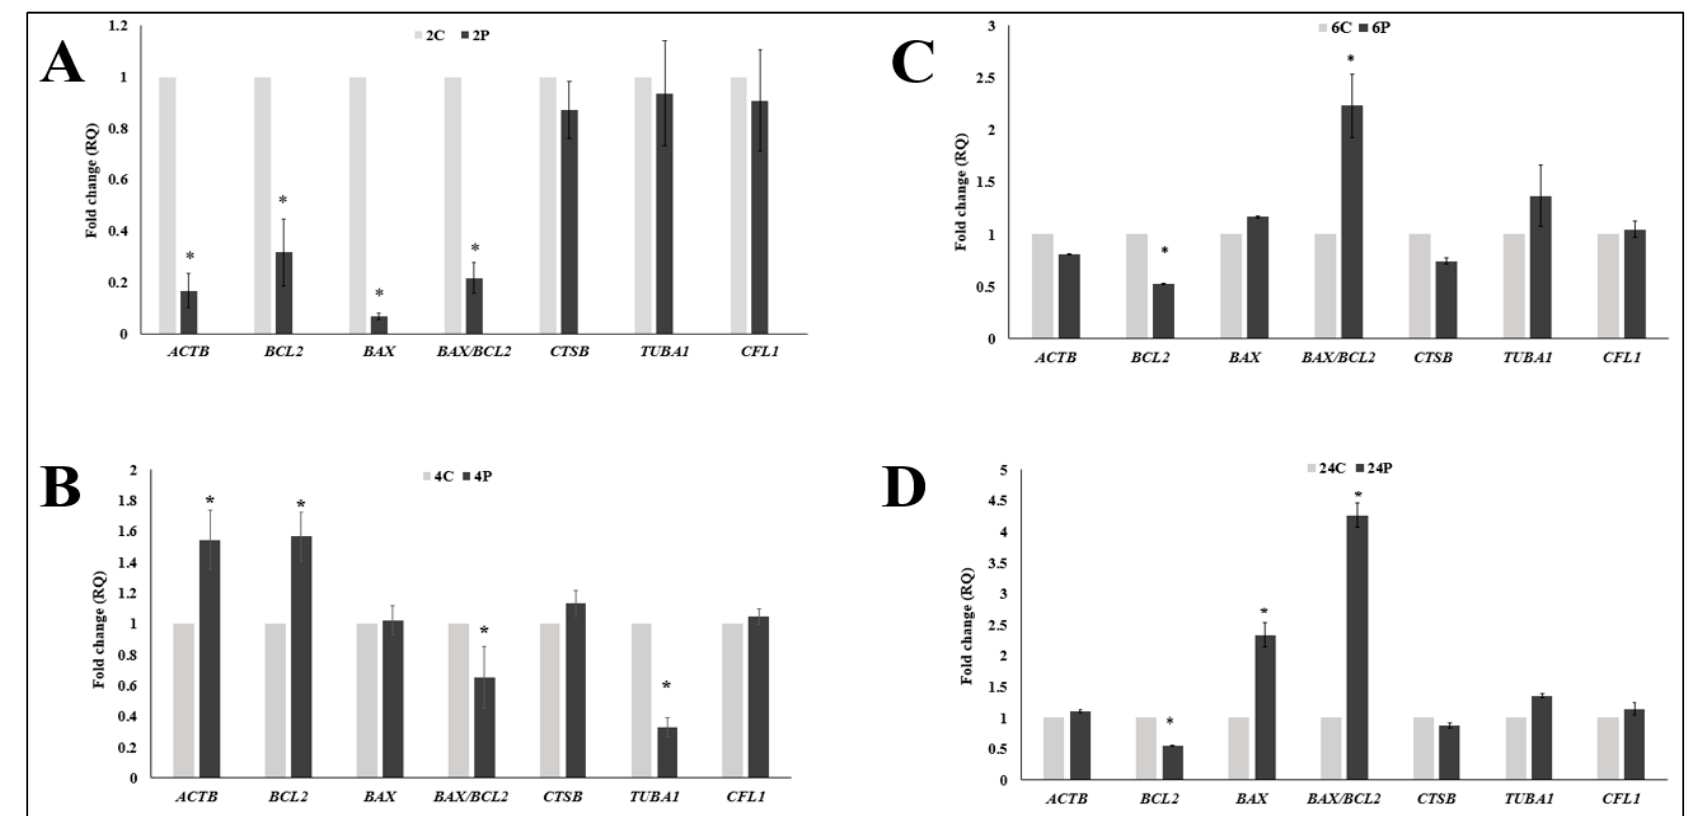
Figure 4. Effect of ROCK-inhibitor supplementation on phase I, pre-IVM for 2 h, 4 h, 6 h, and 24 h on the cytokinesis- and apoptosis-related mRNA transcripts of camel COCs. A to D indicate the treatment groups 2 h, 4 h, 6 h and 24 h respectively. Values were compared to the control groups (without ROCK- inhibitor). Asterisks (*) indicate significant differences ( p < 0.05) between the values. ACTB : beta ( β )-actin protein gene, BCL2 : B-cell lymphoma-2 (Apoptosis regulator, antiapoptotic), BAX : Proapoptotic, BAX/ BCL2: shows the susceptibility to death by apoptosis. The ratio of CTSB: Encodes cathepsin B enzyme which induces apoptosis through the stimulation of Caspase 3, TUBA1 : Encodes alpha-tubulin ( α -tubulin), CFL1 : Encodes cofilin. Gray bars represent the control group, while the dark ones represent the RI-supplemented group.